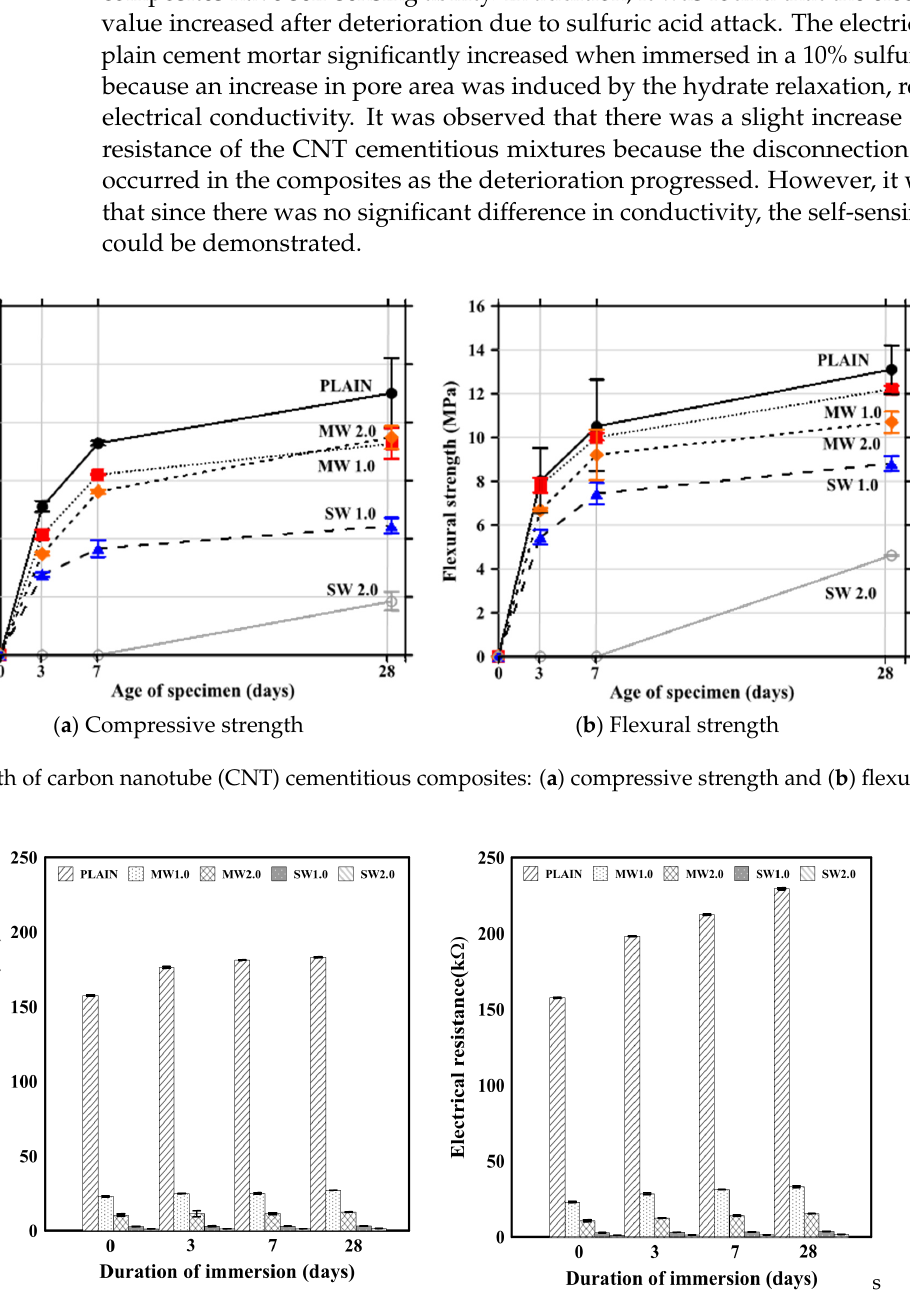
Figure 11. Electrical resistance of CNT cementitious composites before and after deterioration by sulfuric acid: ( a ) 5% and ( b )10%.